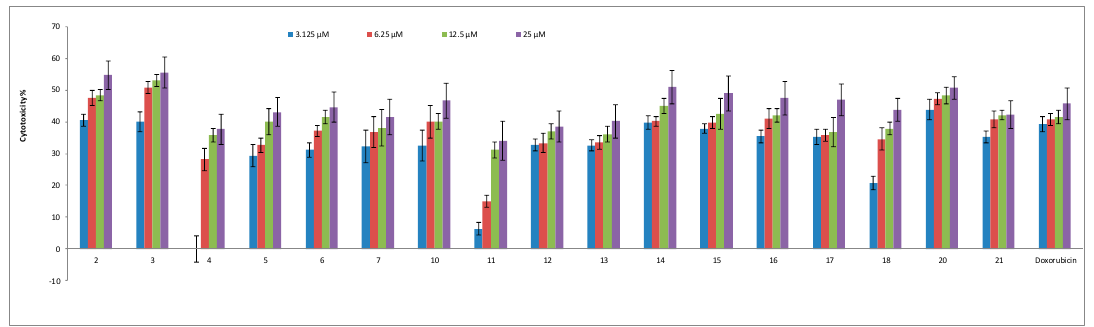
Figure 2. Dose dependent cytotoxic activities of the compounds against HCT-116 cancer cells according to the MTT assay.